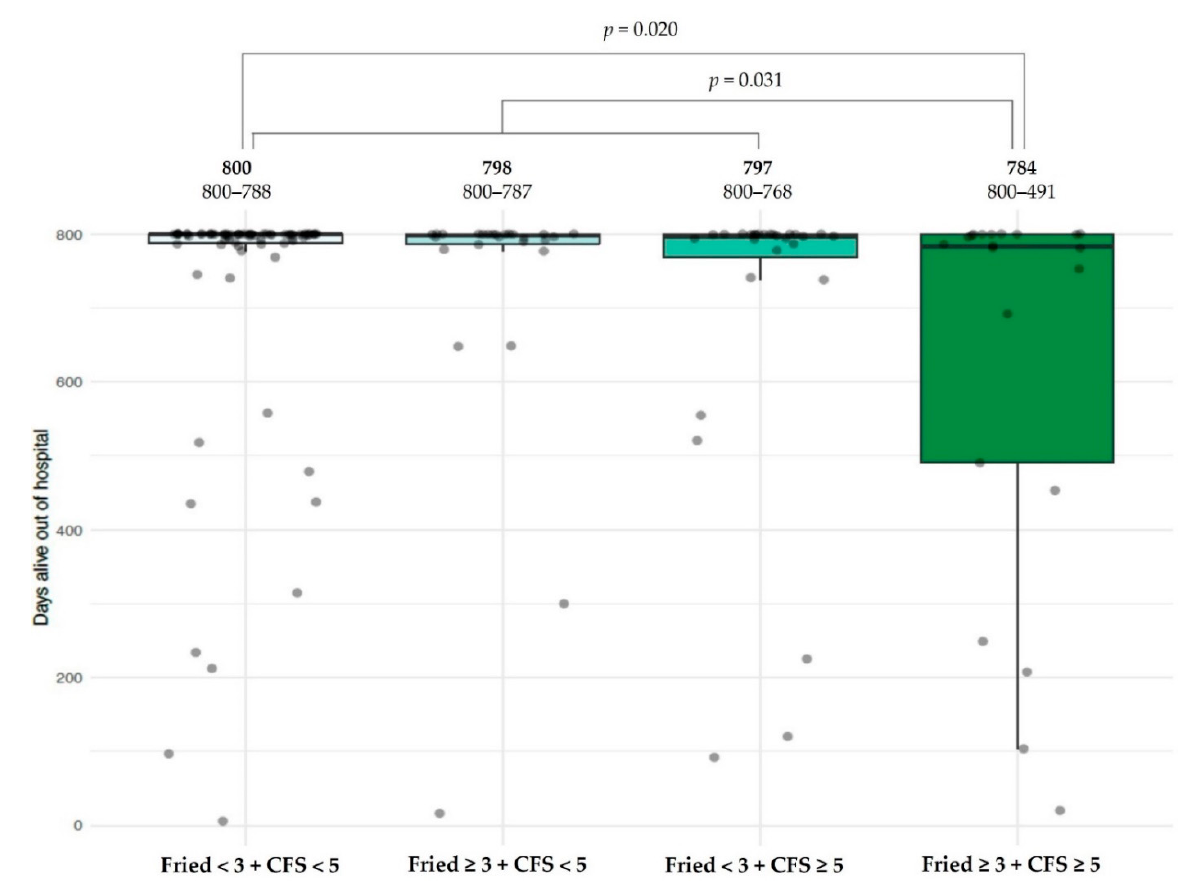
Figure 5. Relationship between primary endpoint (DAOH) and dichotomized (FFS ≥ 3, Clinical Frailty Scale [CFS] ≥ 5) and combined frailty scales. p values are related to univariate analysis.